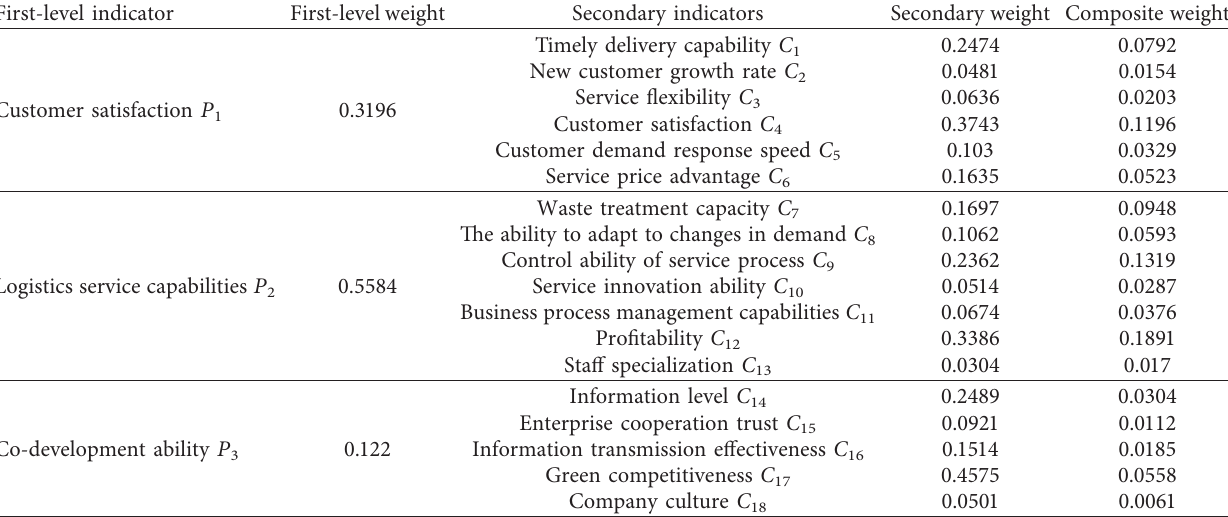
Table 5: Summary of weights of performance evaluation indexes of logistics service supply chain.